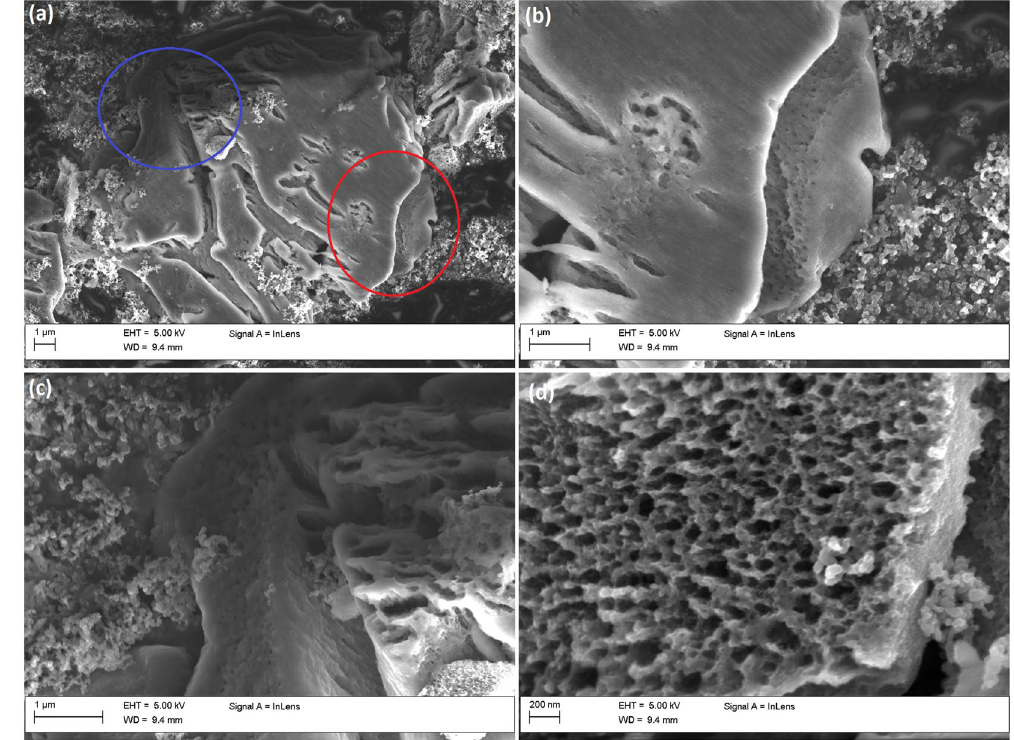
Figure 5. SEM images of particles after 300 cycles. SEM images from individual particles after 300 cycles from TCPSi 38 sample. ( a ) Cracks can be seen in the PSi particle. ( b ) A larger magnification image from ( a ) indicated by the red circle. Pore openings can be seen under the vertical crack in the middle of the image. ( c ) A larger magnification image from ( a ) indicated by a blue circle. Pore openings can be seen on the cracked particle in the middle. ( d ) Top-down view into a cycled particle with enlarged pore openings of approximately 50 nm in